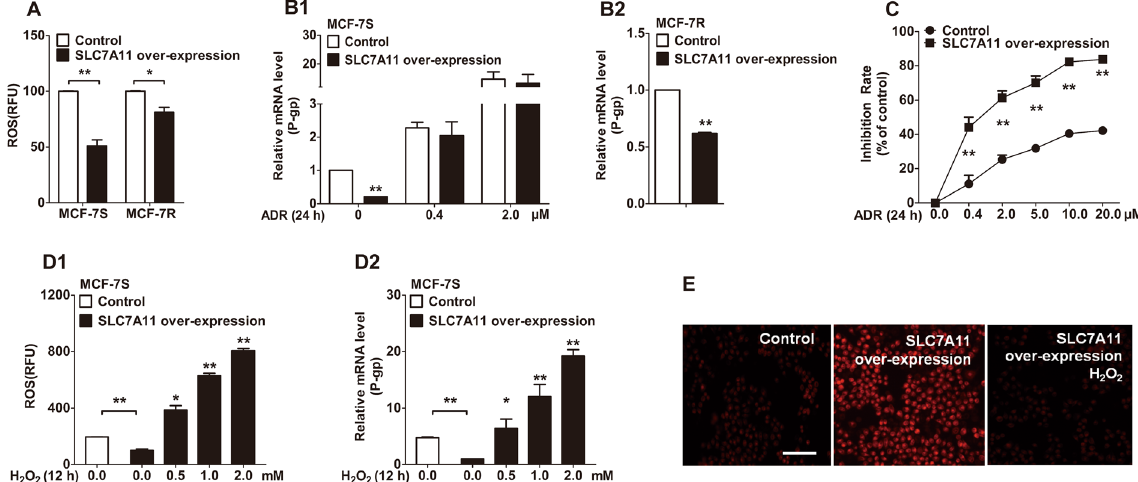
Figure 4. Effect of SLC7A11 over-expression on P-gp expression in MCF-7S and MCF-7R cells. ( A ) SLC7A11 over-expression reduced the ROS level in MCF-7S and MCF-7R cells. ( B ) SLC7A11 over-expression inhibited P-gp mRNA expression in MCF-7S and MCF-7R cells. Furthermore, MCF-7S cells that over-expressed SLC7A11 were more sensitive to ADR, compared to MCF-7S cells that has been exposed to a control vector. ( C ) SLC7A11 over-expression increased the cytotoxic sensitivity of ADR on MCF-7S cells. ( D ) SLC7A11 over- expression reduced ROS levels and P-gp mRNA expression in MCF-7S cells, which could be reversed by H 2 O 2 . ( E ) SLC7A11 over-expression decreased the function of P-gp, which could be reversed by H 2 O 2 (0.25 mM, 24 h), as indicated by intracellular Rho 123 accumulation in MCF-7S cells. Scale bar: 100 μ m. All of the experiments were conducted in triplicate, and data with error bars are presented as the mean ± SD (n = 3). * p < 0.05; ** p < 0.01 vs.